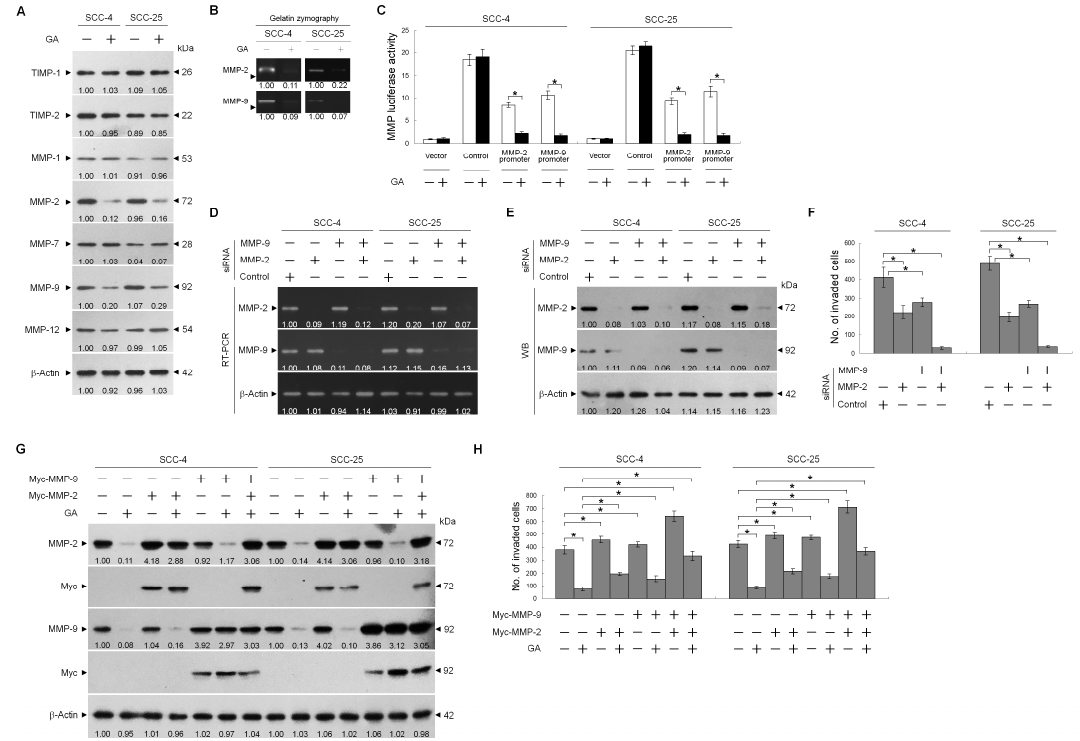
Figure 2. Suppression of tongue squamous carcinoma (TSC) cell invasiveness by gallic acid (GA) involves the downregulation of matrix metalloproteinase-2 (MMP-2) and MMP-9. ( A ) The e ff ect of GA on MMP-2 and MMP-9 expression. The levels of tissue inhibitor of matrix metalloproteinases-1 (TIMP-1), TIMP-2, MMP-1, -2, -7, -9, and -12 in TSC cell lysates that were prepared after 36 h of treatment with vehicle ( − ) or GA (20 µ M) were analyzed using specific antibodies. ( B ) At 36 h, the medium from vehicle- or GA (20 µ M)-treated TSC cells was collected for analysis of the proteolytic activities of MMP-2 and MMP-9 by gel zymography. ( C ) The e ff ect of GA on MMP-2 and MMP-9 promoter activities. TSC cells were co-transfected with the MMP-2 promoter and pCH110 plasmids or with the MMP-9 promoter and pCH110 plasmids for 12 h, followed by vehicle or GA (20 µ M) for an additional 36 h. The MMP-2 and MMP-9 promoter activities in the cell lysates were determined using the luciferase reporter assay. The values are presented as the means ± standard error (S.E.M.) of three independent experiments. * p < 0.05: significantly di ff erent from the vehicle-treated, MMP-2 promoter plasmid-transfected, or MMP-P promoter plasmid-transfected cells. ( D – F ) Involvement of MMP-2 and MMP-9 in the invasiveness of TSC cells. TSC cells were transfected with the indicated small interfering RNAs (siRNAs) for 12 h followed by treatment with vehicle or GA (20 µ M) for an additional 36 h. The levels of MMP-2 and MMP-9 transcripts and proteins in the siRNA-transfected cell lysates were determined by RT-PCR with specific primers and Western blot analysis using specific antibodies, respectively. The values above the figures represent relative density of the bands normalized to β -Actin. The cell invasion activity was determined using the Matrigel invasion assay. * p < 0.05: significantly di ff erent from the vehicle-treated, control siRNA-transfected cells. The values are presented as the S.E.M. of three independent experiments. ( G , H ) The e ff ect of the ectopic expression of the Myc-MMP-2 and Myc-MMP-9 on the suppression of TSC cell invasion by GA. At 1 h after transfection with empty vector, Myc-MMP-2, Myc-MMP-9, or Myc-MMP-2 plus Myc-MMP-9, cells were treated with vehicle ( − ) or GA (20 µ M) for 36 h. The levels of the indicated proteins in the whole cell lysates of transfected cells were determined by Western blot analysis with specific antibodies. The values above the figures represent relative density of the bands normalized to β -Actin. The cell invasion activity was determined using the Matrigel invasion assay. * p < 0.05: significantly di ff erent from the empty vector-transfected vehicle-treated cells or empty vector-transfected GA-treated cells. The values are presented as the S.E.M. of three independent